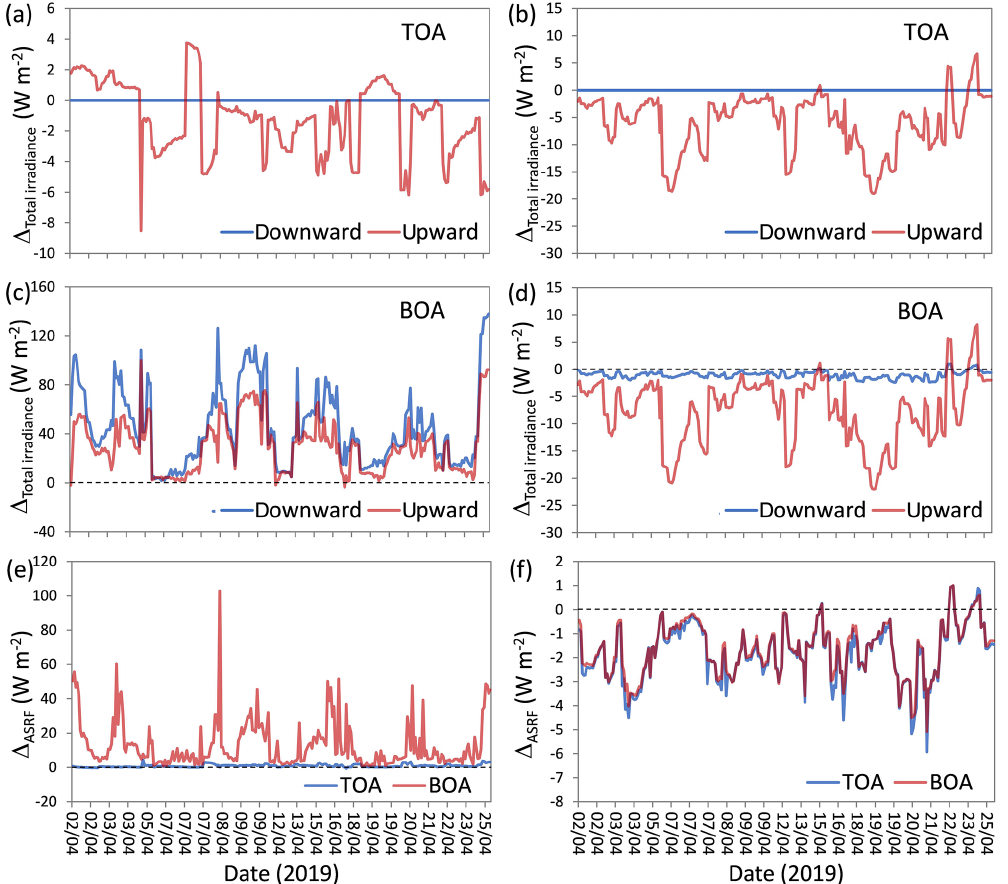
Figure 10. Influence of atmospheric profile (a, c, e) and land surface albedo (b, d, f) on total irradiances and ASRF. (a) Differences of total downward and upward irradiances (TDI and TUI) at the TOA between simulations with the pre-defined midlatitude winter profile and user- specified profiles; (b) differences of TDI and TUI at the TOA between simulations with local noon surface albedo and instantaneous surface albedo; panel (c) is the same as (a) but for BOA; panel (d) is the same as (b) but for BOA; (e) differences of ASRF between simulations with the pre-defined midlatitude winter profile and user-specified profiles at the TOA and BOA; (f) differences of ASRF between simulations with local noon surface albedo and instantaneous surface albedo at the TOA and BOA.